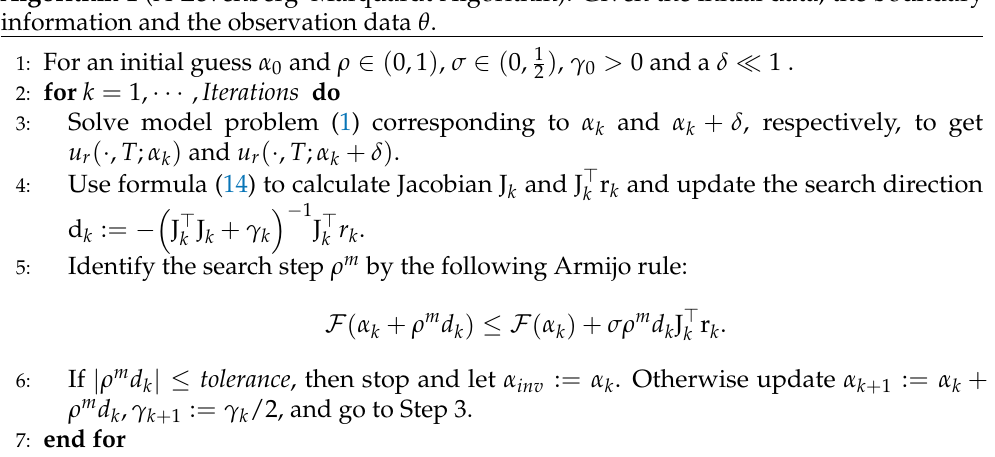
Algorithm 1 (A Levenberg–Marquardt Algorithm): Given the initial data, the boundary information and the observation data θ